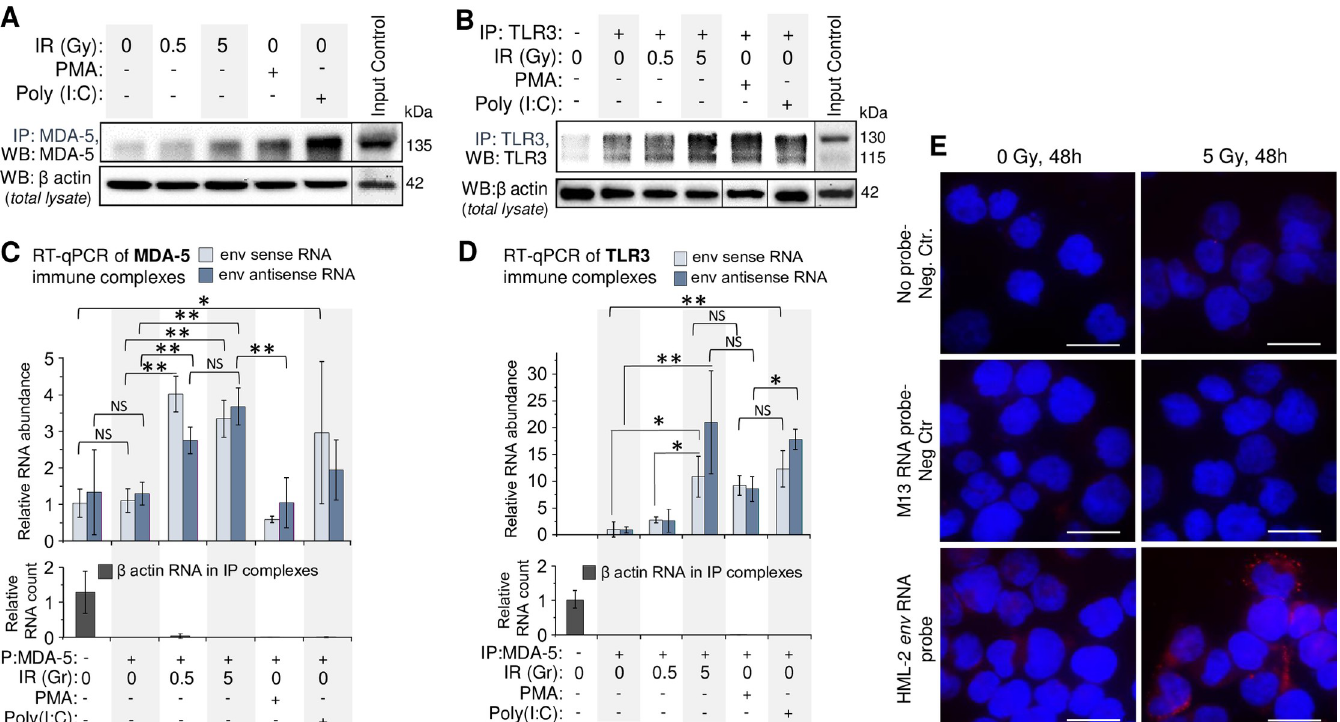
Fig 6. HERVK env RNA is associated with cytoplasmic dsRNA receptors MDA-5 and TLR3 in irradiated monocytes THP1. ( A and B ) Immunoblot of MDA-5 ( A ) and TLR3 ( B ) with mouse monoclonal antibodies in immunocomplexes after IP of these proteins with rabbit polyclonal antibodies from THP1 lysates, exposed to indicated doses of γ IR or treated with PMA or poly(I:C); 48 h post-irradiation. β -Actin in cell lysates, utilized for IP, was used as a reference. ( C and D ) Relative abundance of sense and antisense HERVK HML-2 env RNA in immunocomplexes after RNP-immunoprecipitation (RIP) of MDA-5 ( C ) and TLR3 ( D ) from THP1 lysates, shown on panels A and B. The fold change RNA count ( ΔΔ Ct) was calculated in relation to β -actin reference RNA, detected in the lysates used for RIP. Error bars: ± SD of three independent replicates; � p < 0.05, �� p < 0.01, NS non-significant. ( E ) PLA assay visualizing association of HML-2 env RNA with MDA-5 receptor in THP1 in irradiated or control cells; 48h post-IR. Nuclei–DAPI staining, MDA-5/RNA complexes–Texas Red. Scale bars: 30 μ m.